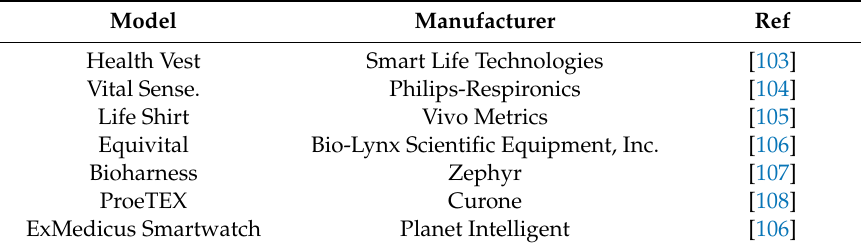
Table 3. Remote monitoring vests and their power